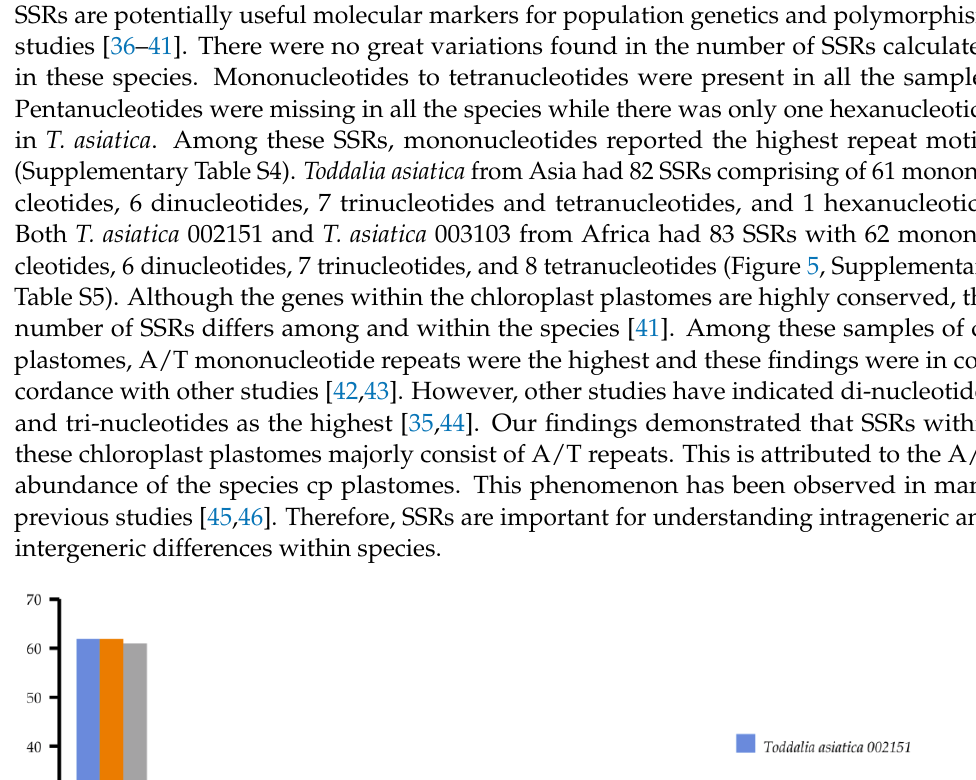
Figure 4. Total number of repeats found in Toddalia species.